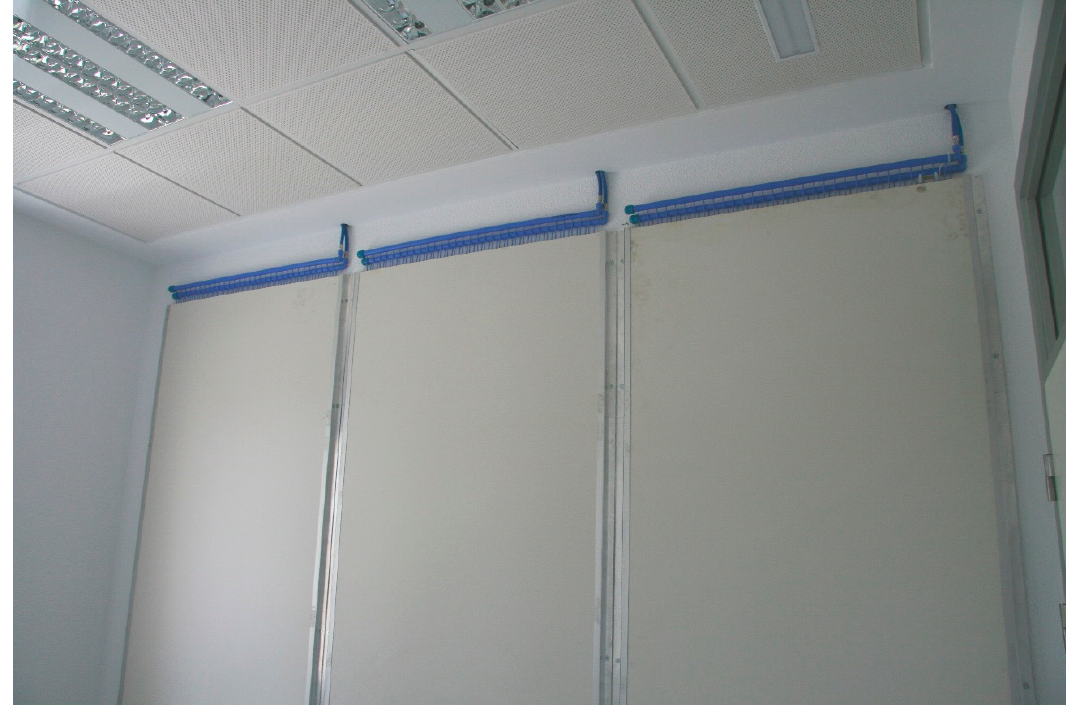
Figure 2. Application of thermal ceramic panels (TCP) thermal ceramic panels in an office of the University of Alicante.